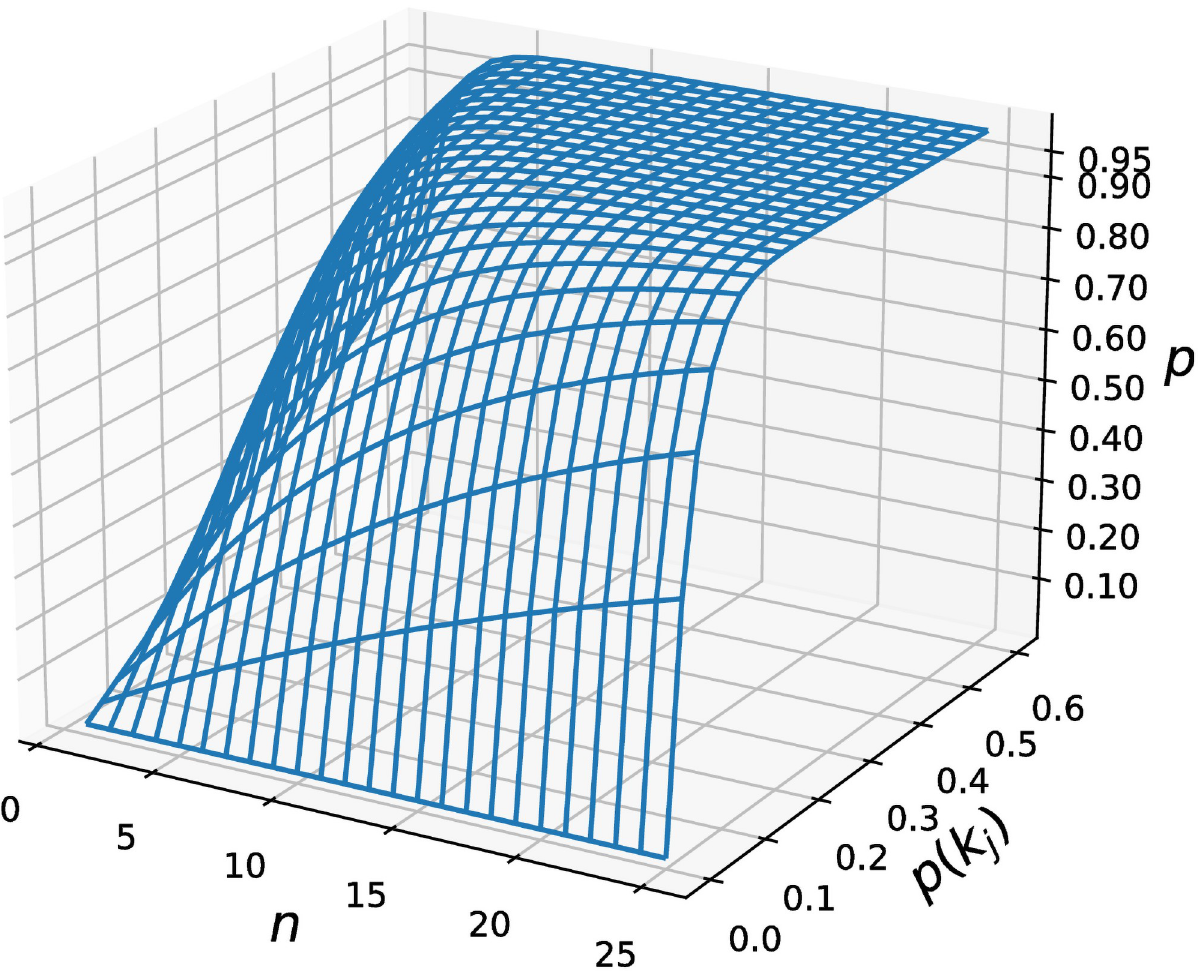
Fig 3. Probabilities of two reads being clustered into one block at lease once in the n rounds of indexing. The horizontal lines in the curved grid are scaled at step interval